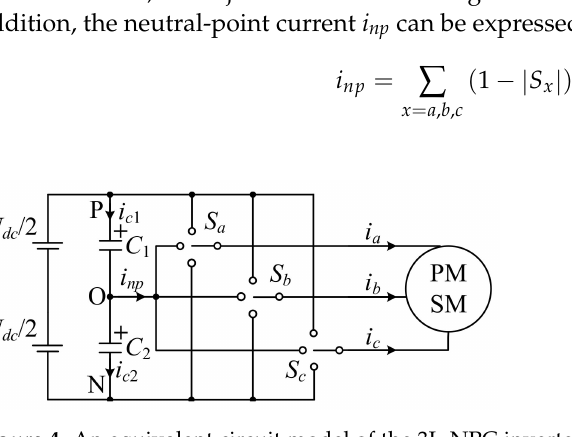
Figure 4. An equivalent circuit model of the 3L-NPC inverter-fed